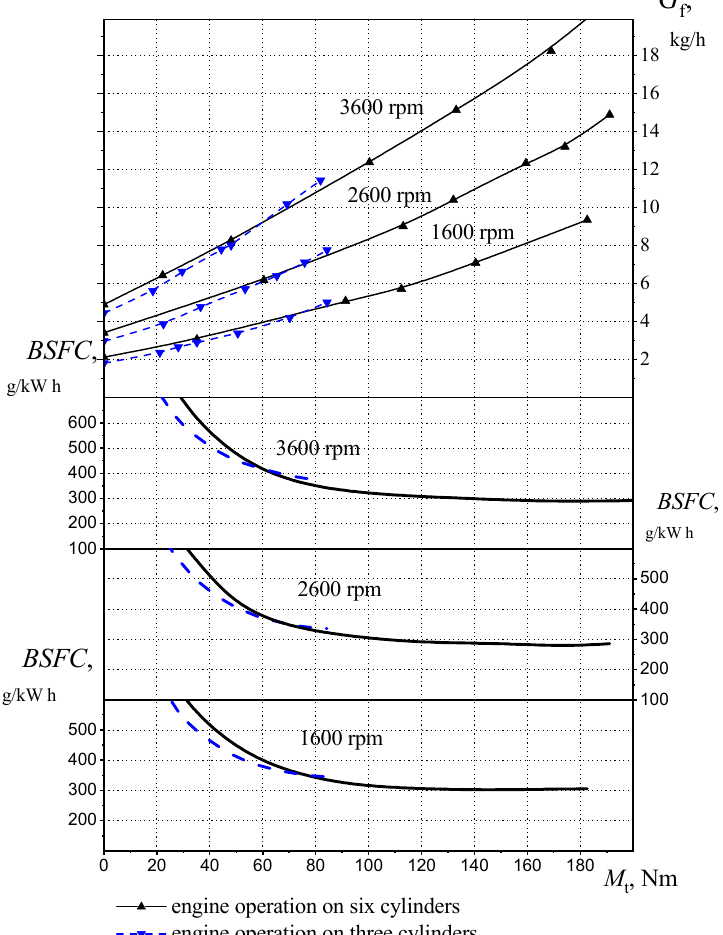
Figure 9. Load characteristics of the Opel C30 LE engine at different speeds operating with three and six cylinders.